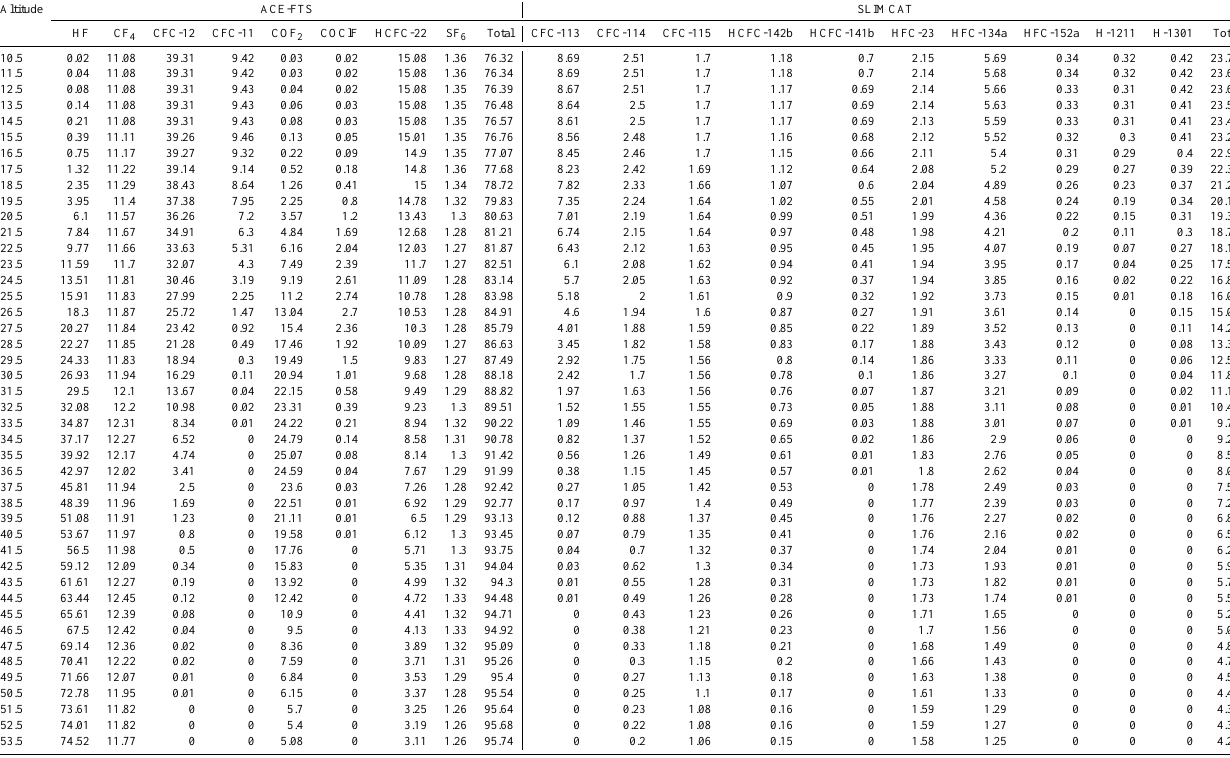
Table A3. The percentage contribution of each species to the total fluorine budget in the latitude bands between 0 ◦ N and 30 ◦ S. Altitude ACE-FTS